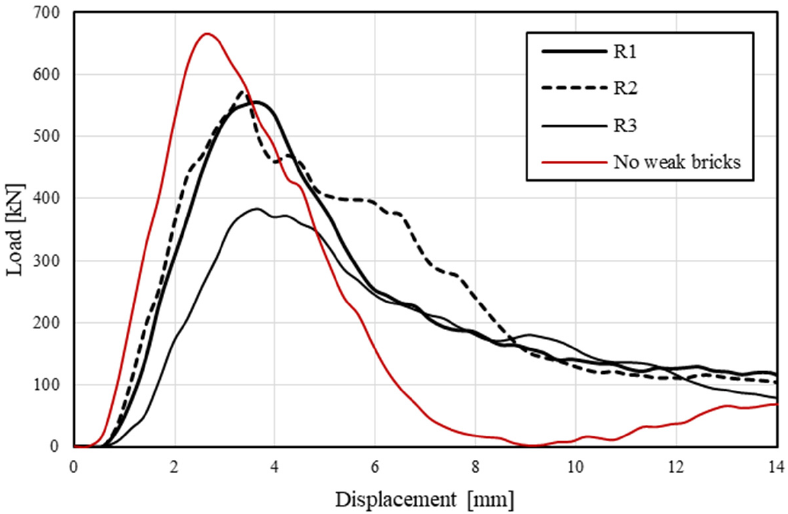
Figure 14. Load vs. displacement curves for different weak-brick patterns.